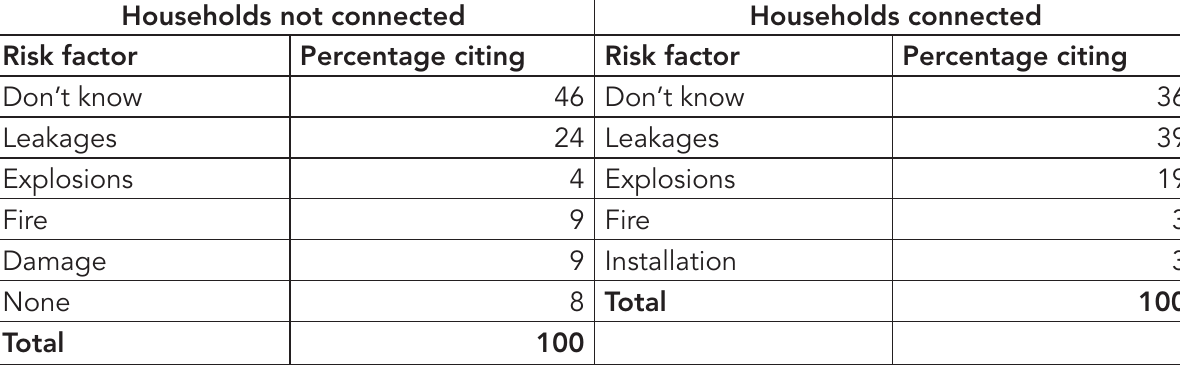
Table 3: Perceived risks by the public Source: Authors’